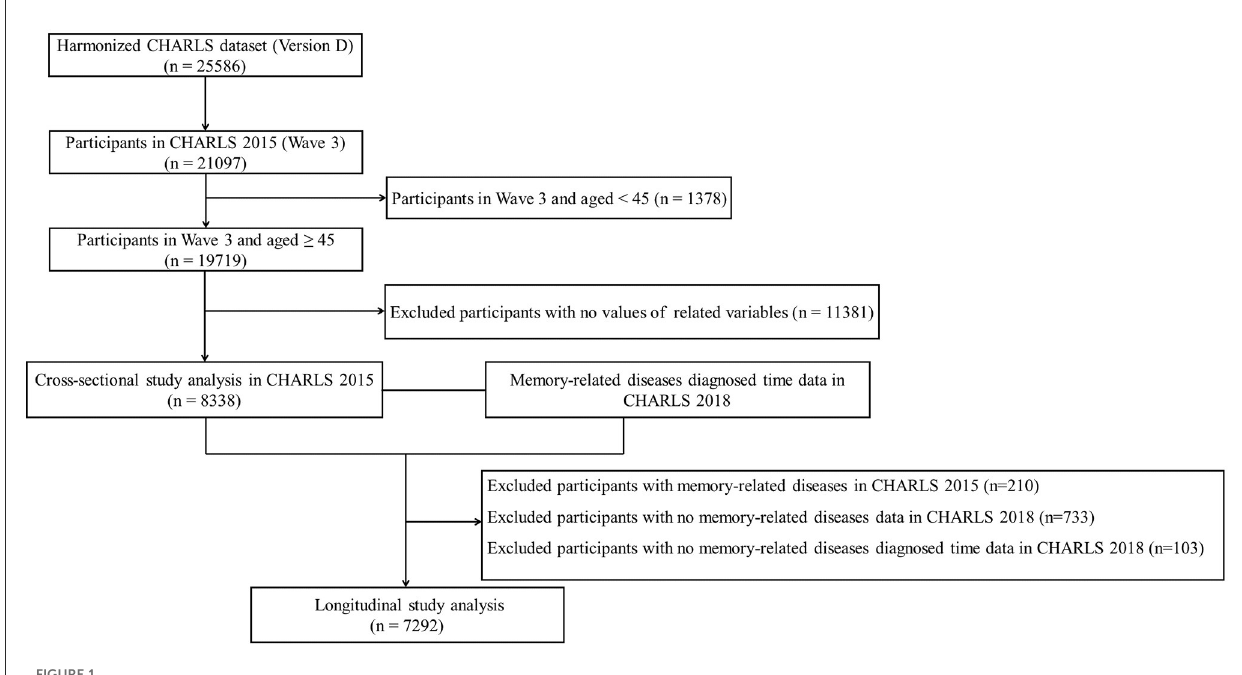
FIGURE1 Flowchart of participants included in the study.